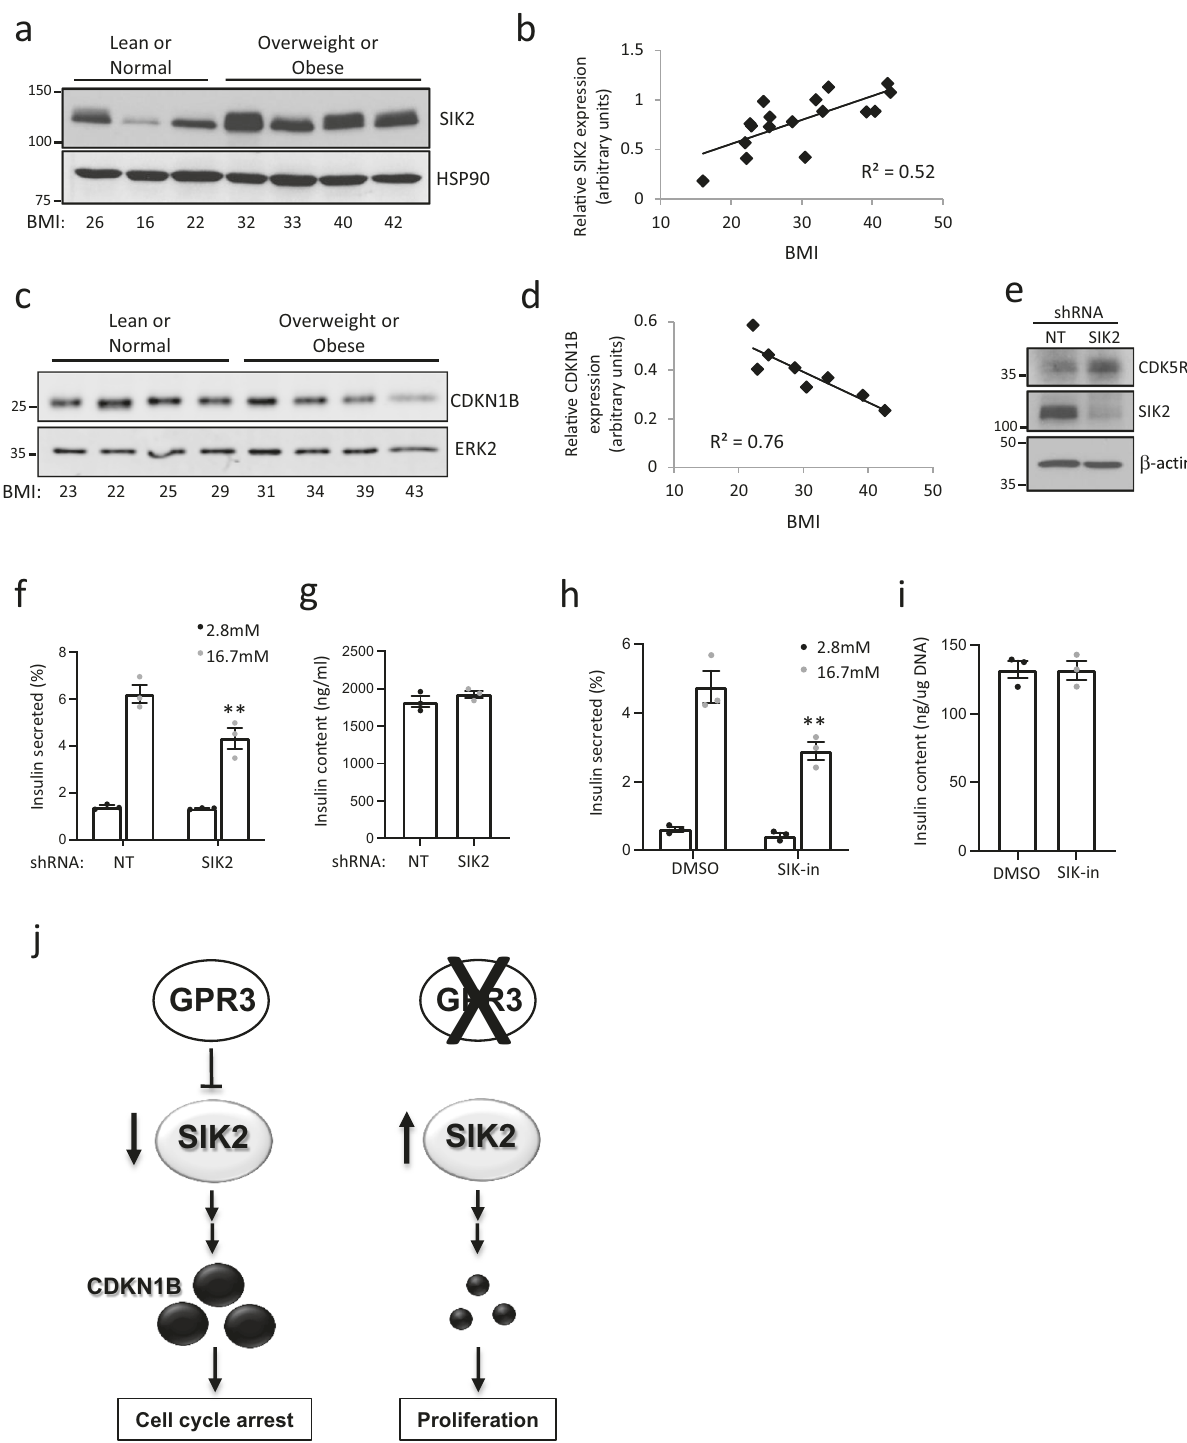
Fig. 6 SIK2 promotes human β cell function. a Western blots showing levels of SIK2 protein and HSP90 loading control in isolated human islets from non- diabetic human subjects of increasing BMI. b Line plot showing a correlation between SIK2 levels in isolated human islets and subject ’ s BMI; r 2 = 0.52. c Western blots showing levels of CDKN1B protein and ERK2 loading control in isolated human islets from non-diabetic human subjects of increasing BMI. d Line plot showing a correlation between SIK2 levels in isolated human islets and subject ’ s BMI; r 2 = 0.76. e Western blot showing levels of SIK2 and its substrate CDK5R1/p35 following silencing of SIK2 compared to NT control. f Barplots showing insulin secretion in response to 16.7 mM glucose following silencing of SIK2 in isolated human islets compared to NT control. p -value = 0.0327. g Insulin content in islets shown in ( f ). h Barplot showing the effect of SIK-in on GSIS in isolated human islets compared to DMSO control. p -value = 0.0364. i Insulin content in islets shown in ( h ). For ( f ) – ( i ), bar plots are representative of n = 3 donors. For each plot, error bars are de fi ned as the standard error of the mean of three technical replicates. j Model showing GPR3 promoting CDKN1B accumulation to maintain cell cycle arrest via inhibition of SIK2. When GPR3 is silenced, SIK2 becomes active and CDKN1B is lost, facilitating cell cycle entry. MWs for Western blot markers are in